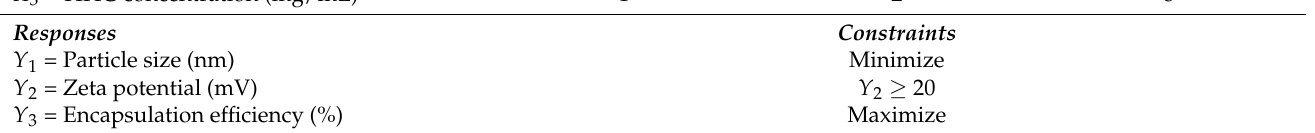
Table 1. Factors and responses in Box–Behnken design for fabrication of HHC-CS-NPs. Level Used Low ( − 1) Medium (0) High (+1) 0.6 0.7